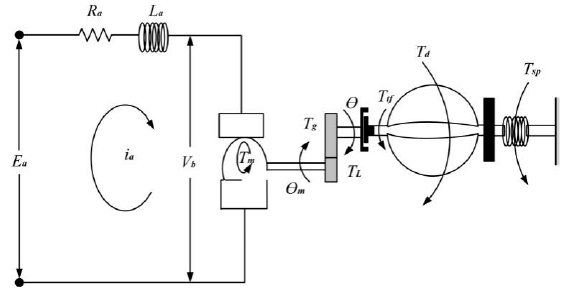
Figure 1. The structure of electronic throttle.